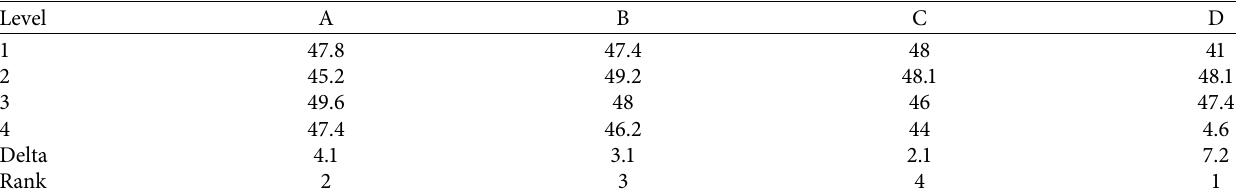
Table 6: SNR (signal to noise